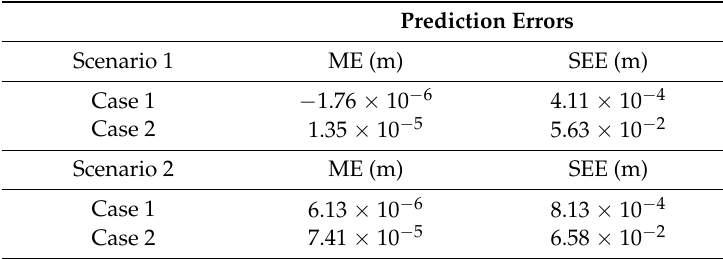
Table 6. The prediction errors of leak detection in two